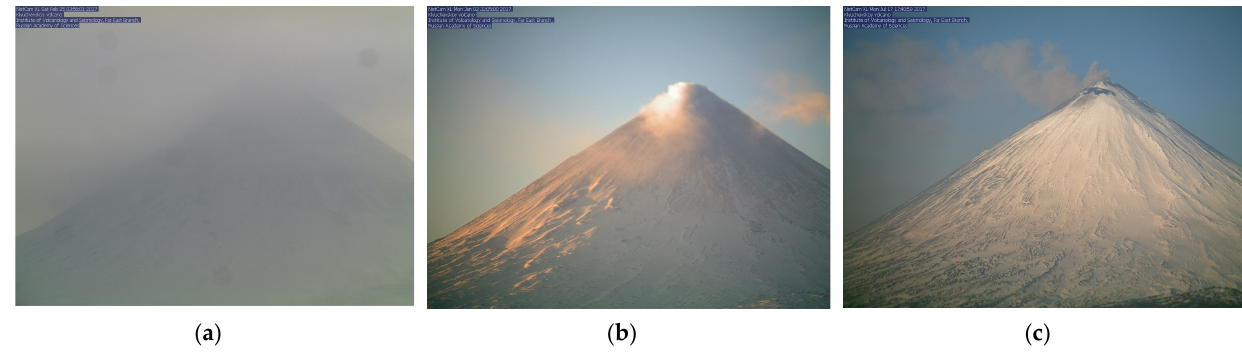
Figure 16. Examples of Klyuchevskoy volcano images, classified by convolutional neural network: ( a ) uninformative image